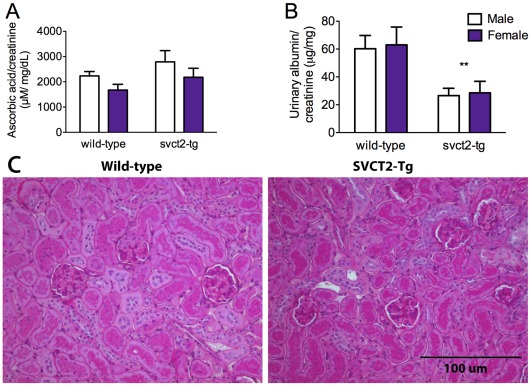
Kidney Function in SVCT2-Tg mice.Excreted (A) ASC and (B) albumin were measured in urine samples with the results normalized to creatinine. Data shown are mean+S.E.M for wild-type and SVCT2-Tg mice separately for male (white bars) and female (purple bars) mice. ** p<0.01 compared to wild-type control. N = 5−6 mice per group. (C) 2 µm sections stained with hemotoxylin and eosin (H&E) for comparison between genotypes. Glomeruli, proximal tubules and distal tubules are all clearly visible but no changes were observable in SVCT2-Tg mice (right panel) compared to wild-types (left panel). Images taken at 20X magnification.